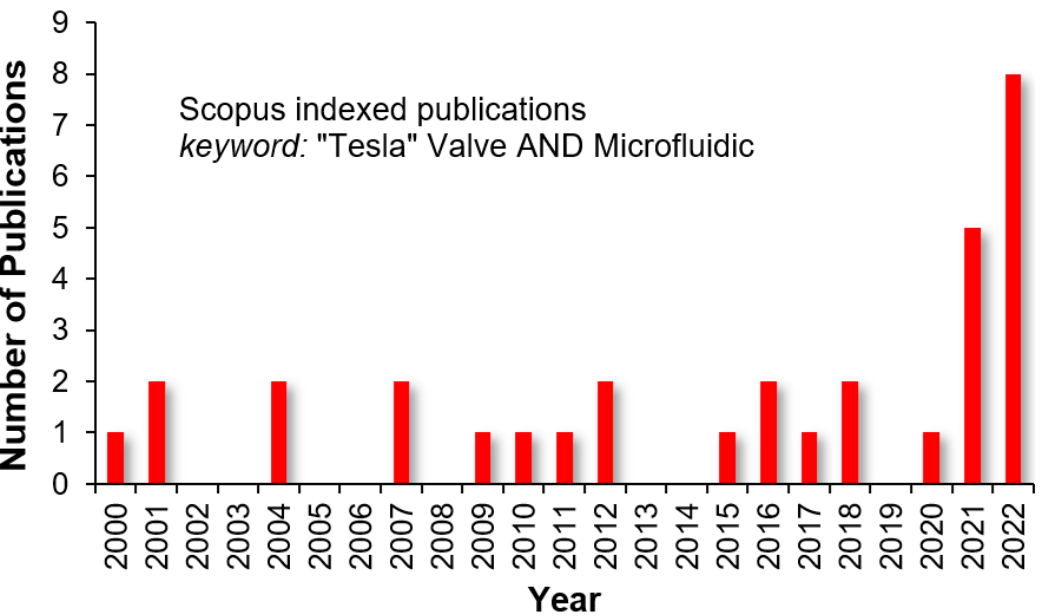
Figure 2. The trend of TV microfluidics publications, based on the Scopus index for the time range until 2022.